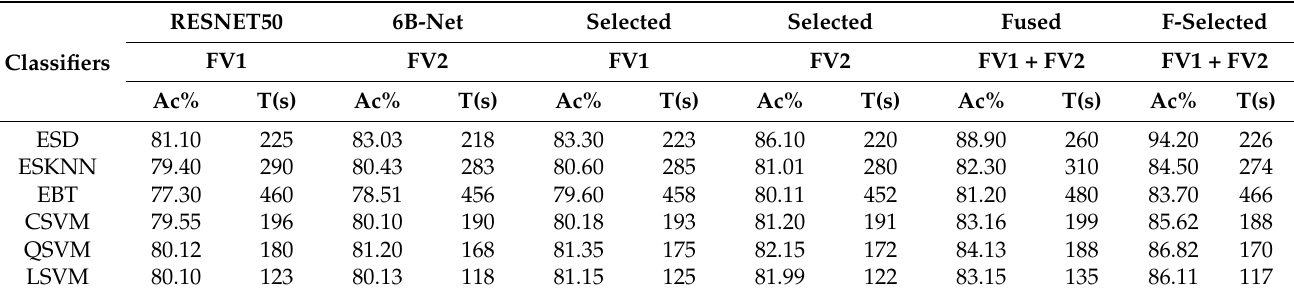
Table 4. Results using the proposed method on breast cancer pathology dataset with ten-fold validation, where Ac% represents the accuracy in percent, and T(S) represents the training time in seconds.